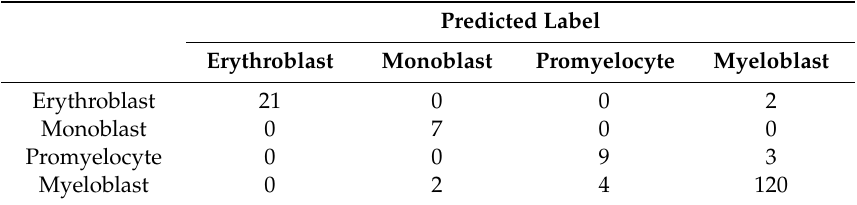
Table 6. Confusion matrix for optimized classification of immature leukocytes.